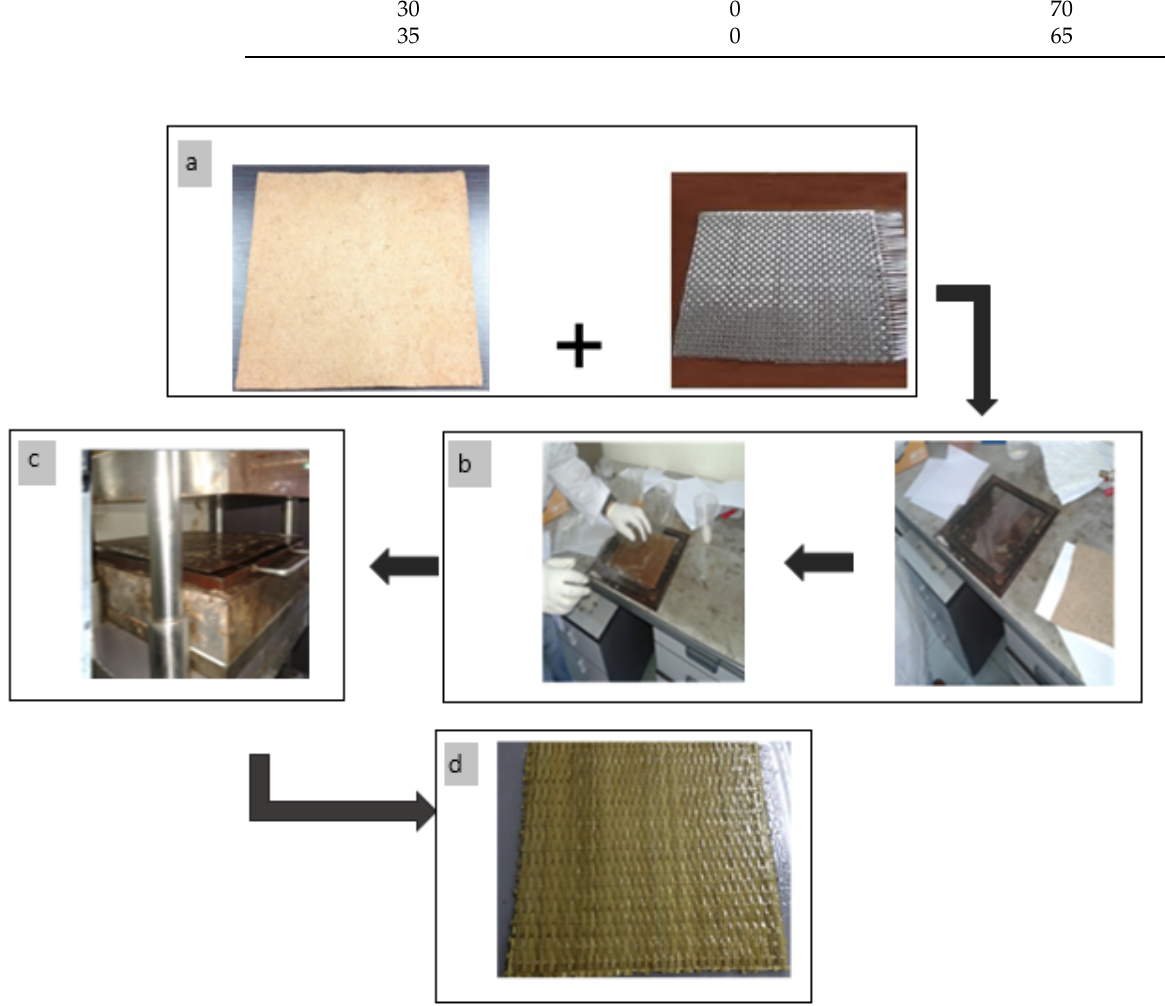
Figure 1. Fabrication method for KBF/GF hybrid composite; ( a ) KBF mat and GF mat; ( b ) placement of KBF at the stainless steel mold; ( c ) cold-pressed of the mold; ( d ) cured sample.